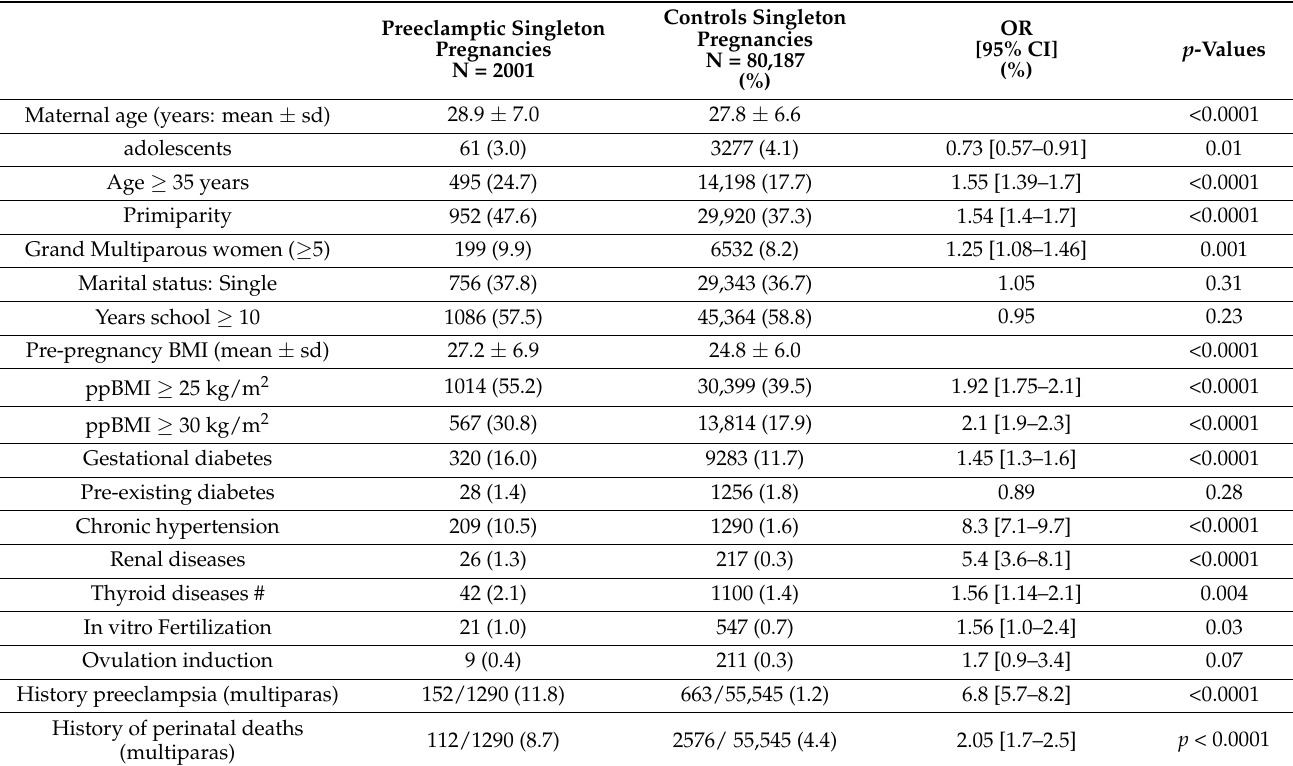
Table 1. Maternal and pregnancy